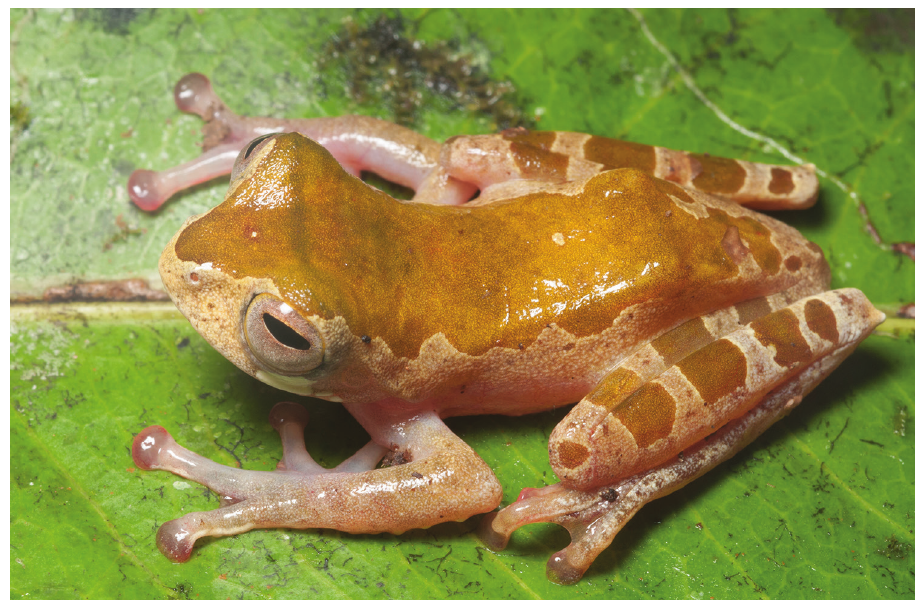
Figure 36. Rhacophorus bimaculatus male (KU 333195) from Mt. Lumot, Municipality of Gingoog City, Misamis Oriental Province. Photo: